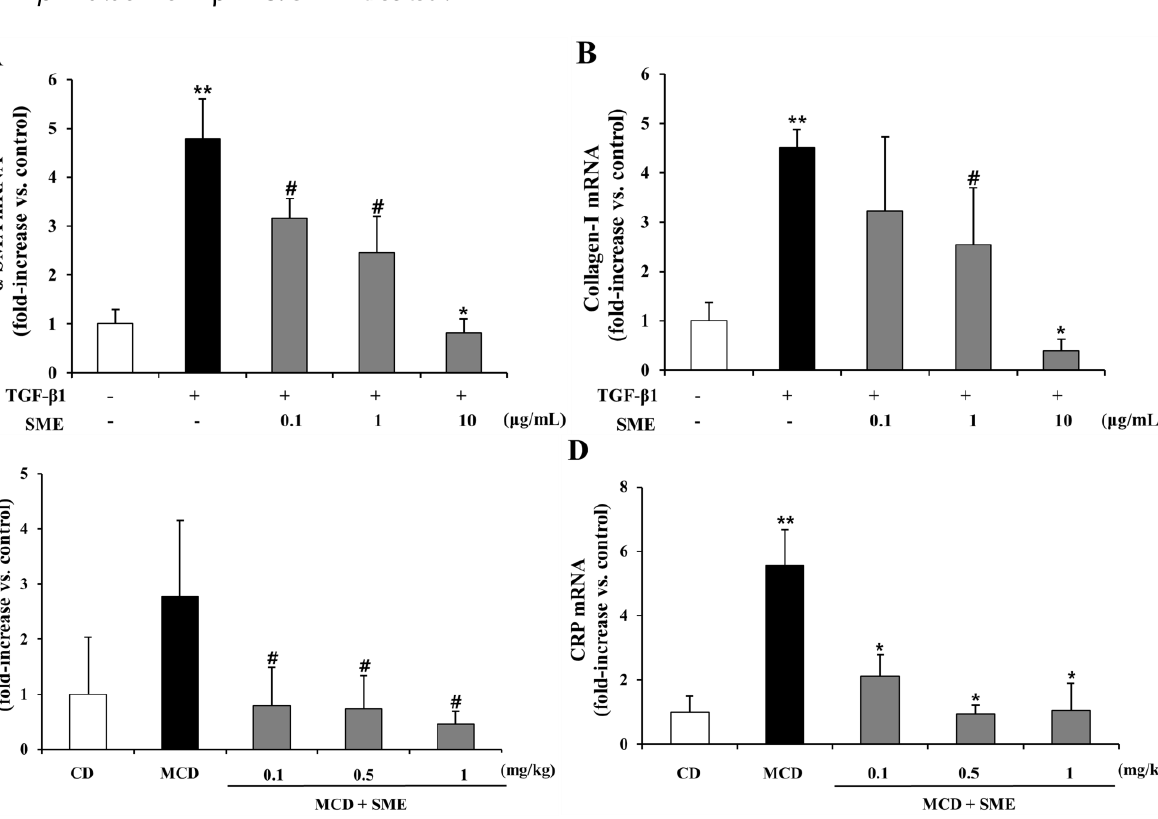
2 . 8 . Effect of SME on mRNA Expression of NASH-Related Specific Genes in HSCs Induced by TGF-β1 TGF-β1 plays a pivotal role in hepatic fibrogenesis through HSC activation and increased synthesis of α-SMA and various ECM-related factors such as collagen I, MMP-2 and MMP-9 [16,17,19]. Figure 7. Effect of SME on mRNA expression of NASH-related specific genes in TGF-β1 induced LX-2 cells Comparison of LX-2 cells treated with TGF-β1 only (control) and SME plus TGF-β1 for 24 h. ( A ) α-SMA; ( B ) Collagen-I; ( C ) MMP-2; ( D ) MMP-9; ( E ) TNF-α; ( F ) IL-1β; ( G ) CRP. The mRNA expression level, normalized to GAPDH levels, is represented as fold induction of control and shown as mean ± SD ( n = 9 per group), ** p < 0.01 vs. untreated; ## p < 0.05 vs. untreated; * p < 0.01 TGF-β1 vs. SME treated; # p < 0.05 TGF-β1 vs. SME